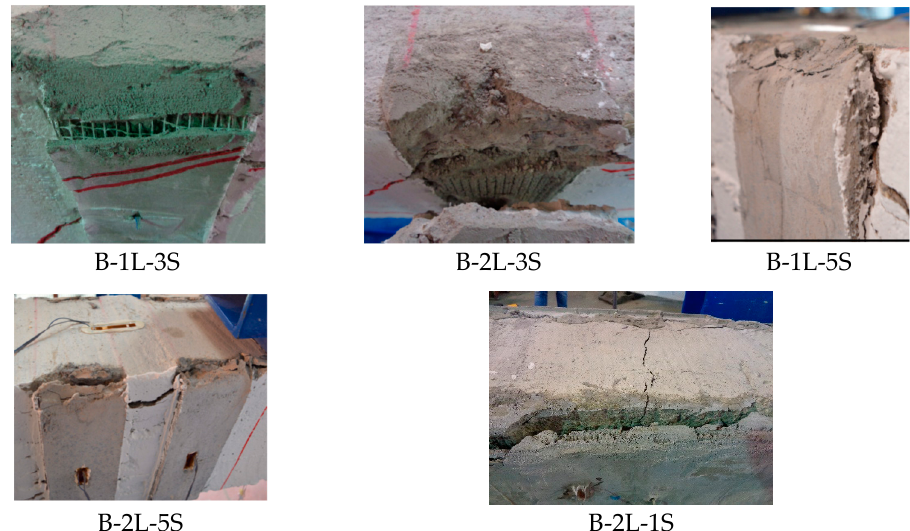
Figure 9. Debonding of the U strips at failure.